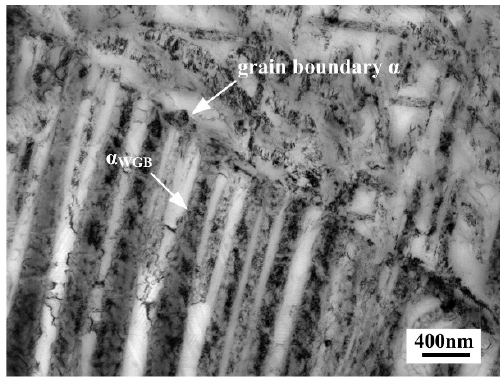
Figure 5. TEM micrograph of